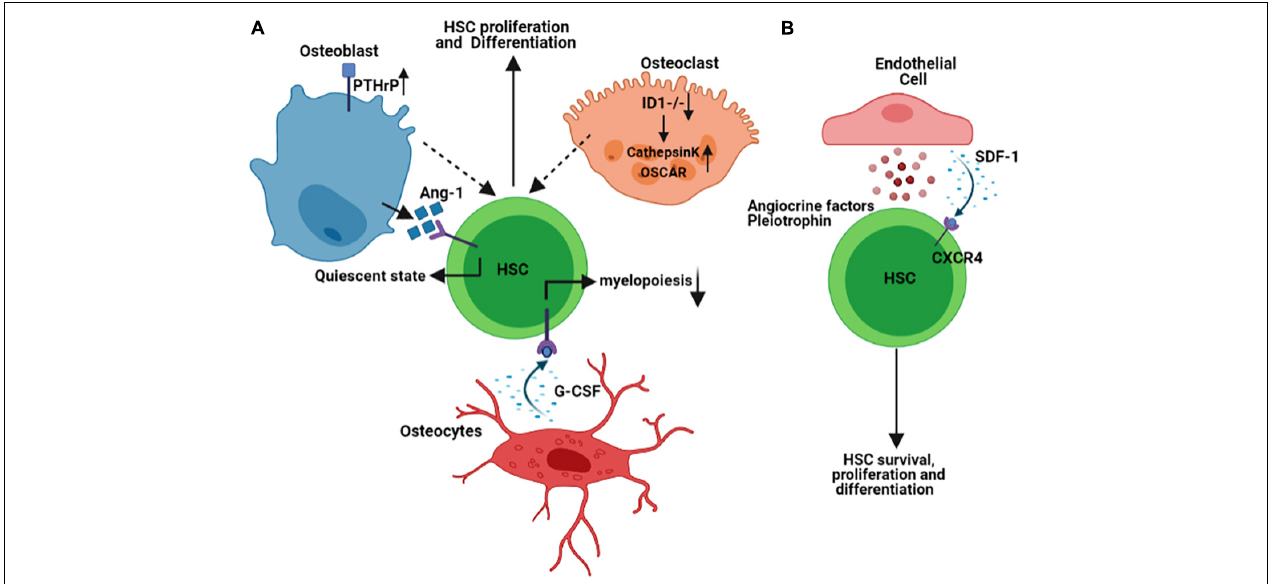
FIGURE 1 | Schematic representation summarizing some of the Hematopoietic Stem Cells (HSCs) interaction with the cells of endosteal (A) and vascular (B) niches within the BM microenvironment. Figures are generated by BioRender.com. expresses factors that regulate hematopoiesis and undergoes widespread transcriptional remodeling under stress condition (Tikhonova et al., 2019). Consistent with this observation, the stress conditions imposed by the growth of malignant cells could modify the characteristics of the BM niches, thus impacting the proper HSCs